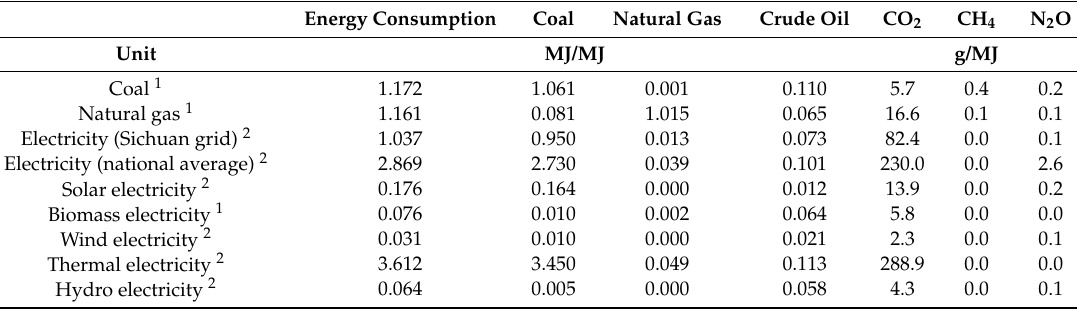
Table 6. Life-cycle analysis coefficient data used in this study.